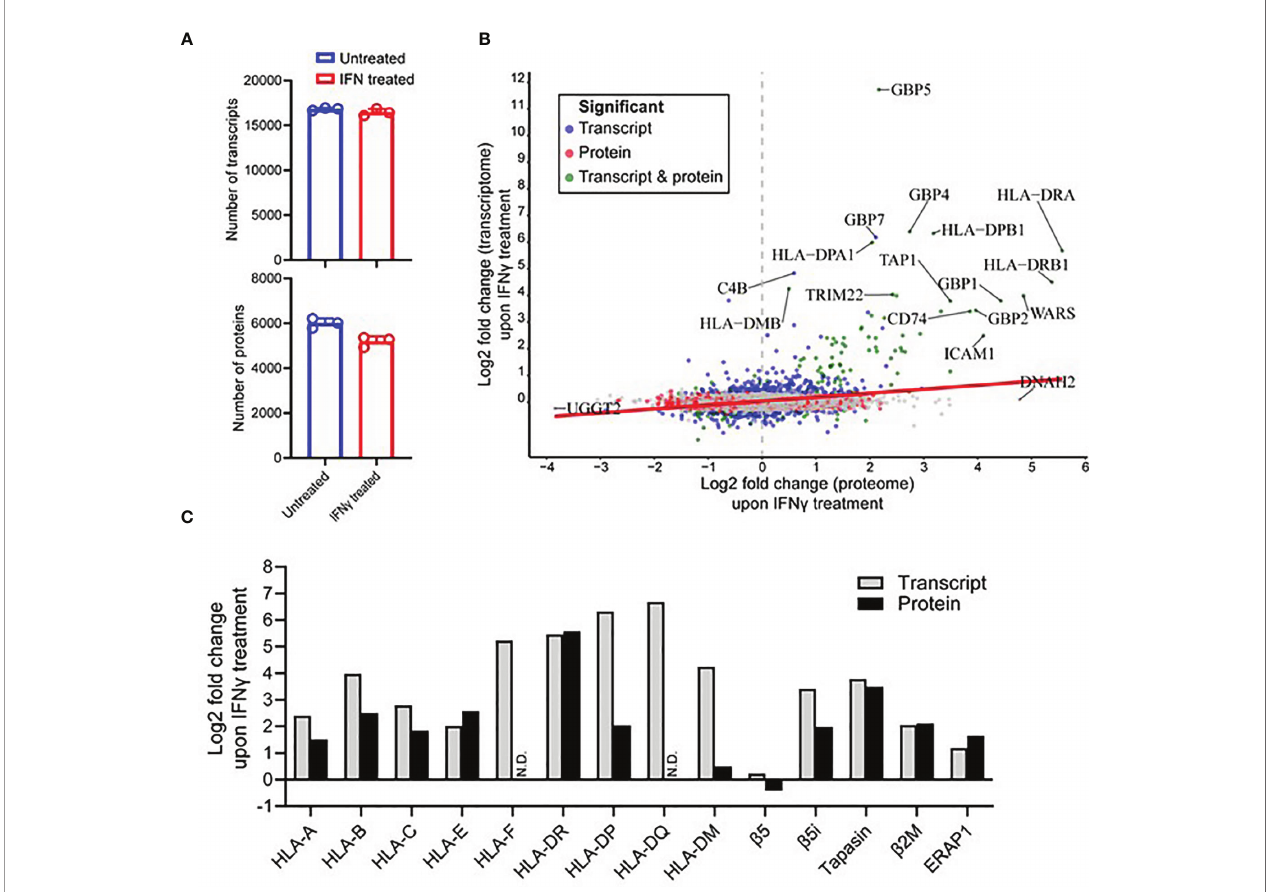
FIGURE 4 | IFN g treatment predominantly induces components of the antigen processing and presentation machinery of MDA-MB-231 cells. (A) The number of transcripts (upper) and proteins (lower) identi fi ed from untreated and IFN g treated cells. Data are from three biological replicates. *p = 0112 by unpaired t-test. (B) Correlation between the Log 2 fold change (IFN g treated compared to untreated) transcripts and proteins. Signi fi cant fold changes at the protein (red), transcript (blue), or protein and transcript (green) level are indicated, with the gene symbols of those with the highest fold-changes indicated. Person correlation coef fi cient of 0.275, p value <0.0001. (C) The log 2 fold change of transcriptome and proteome changes within key components of the antigen processing and presentation machinery following IFN g